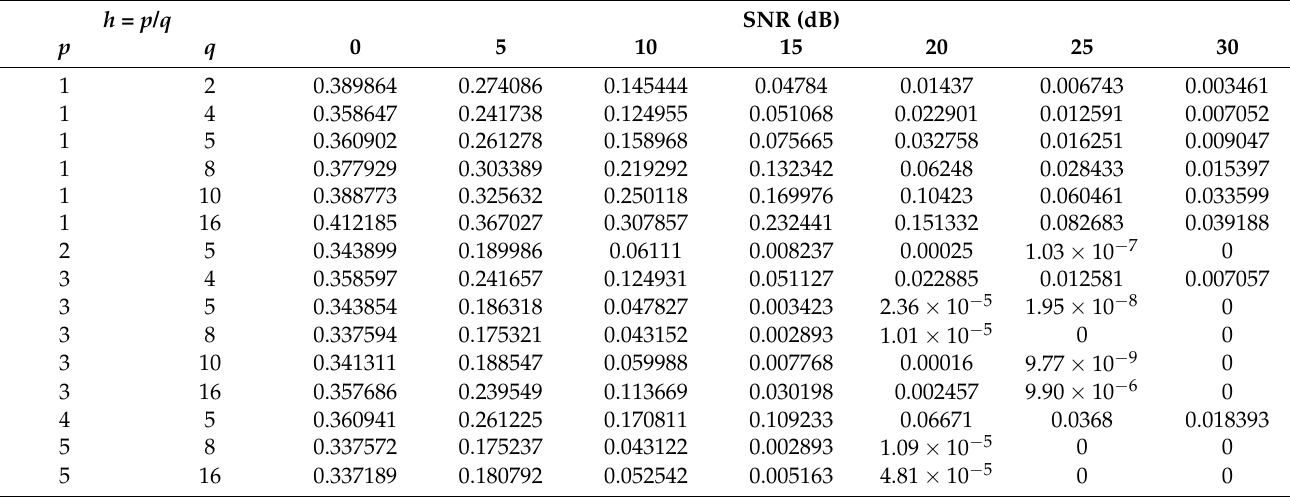
Table 2. BER values for various modulation indices and SNRs (sorted on values of p and q). SNR (dB) h = p / q